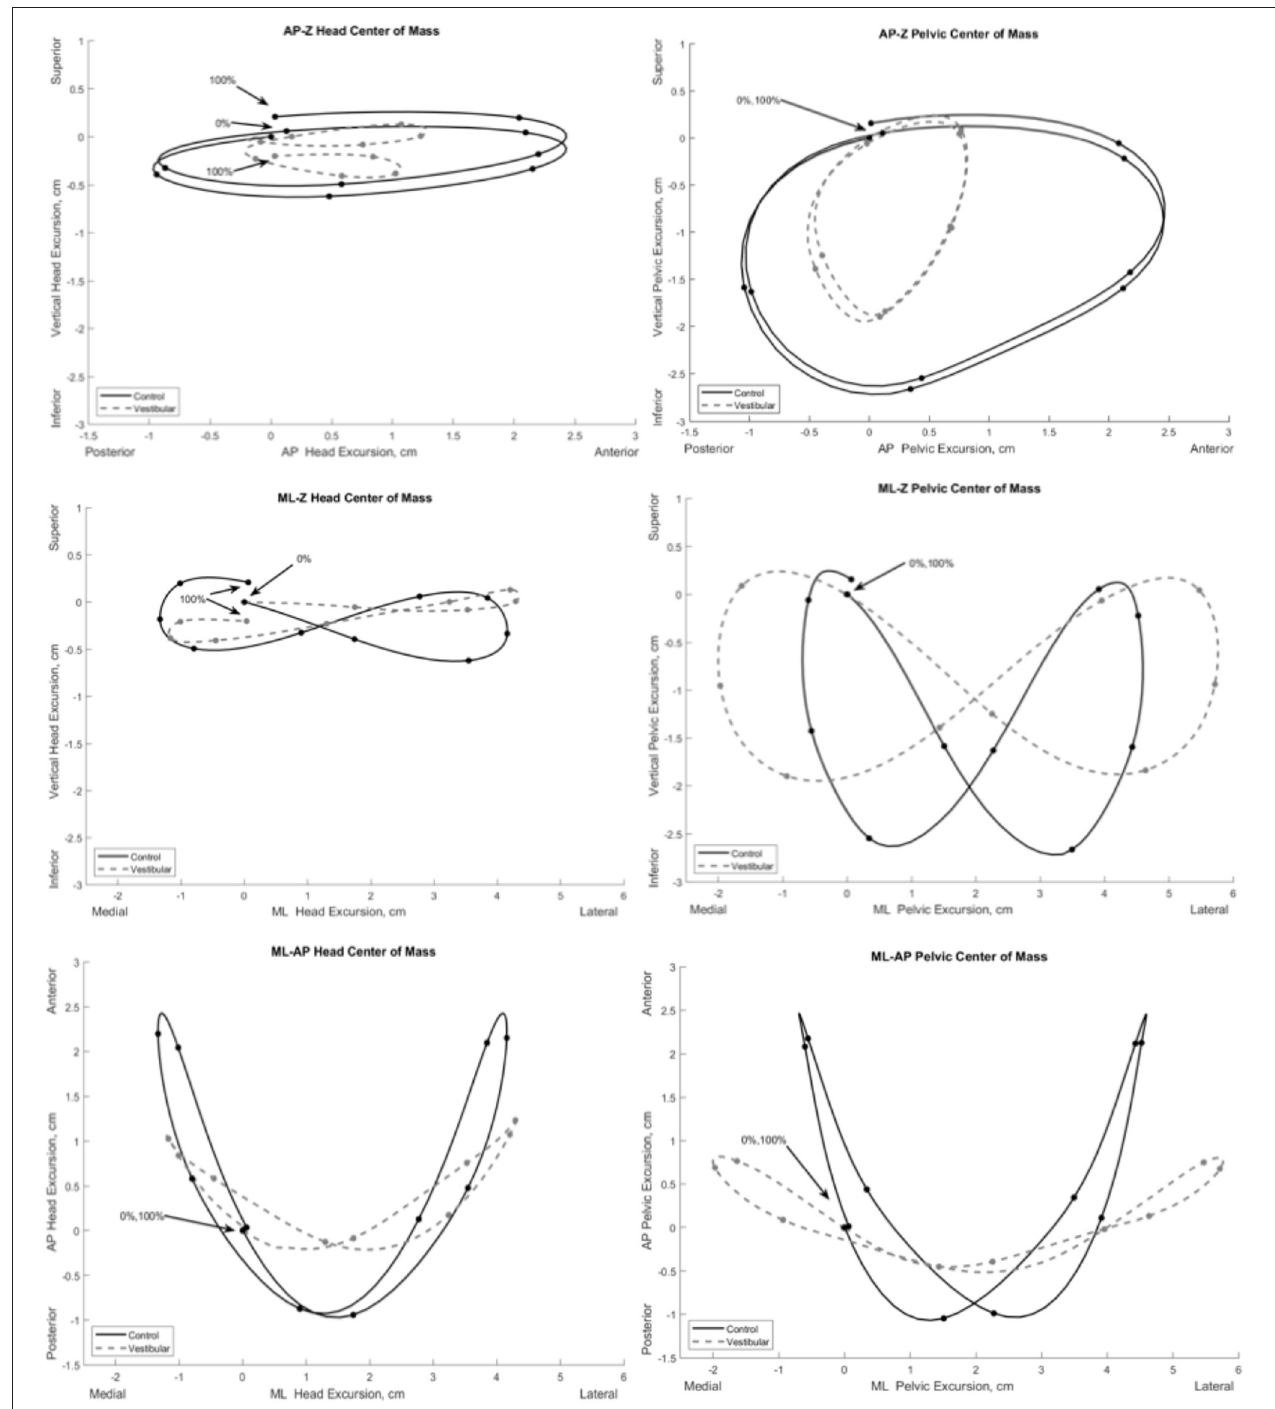
FIGURE 2 | Mean three-dimensional excursion of the head and pelvis during gait in the Vestibular (dashed line) and Control (solid line) groups. Each point on the line depicts 10% increments of the gait cycle starting at initial contact (0%) to ipsilateral initial contact (100%). AP, anteroposterior; ML, mediolateral; Z, vertical.